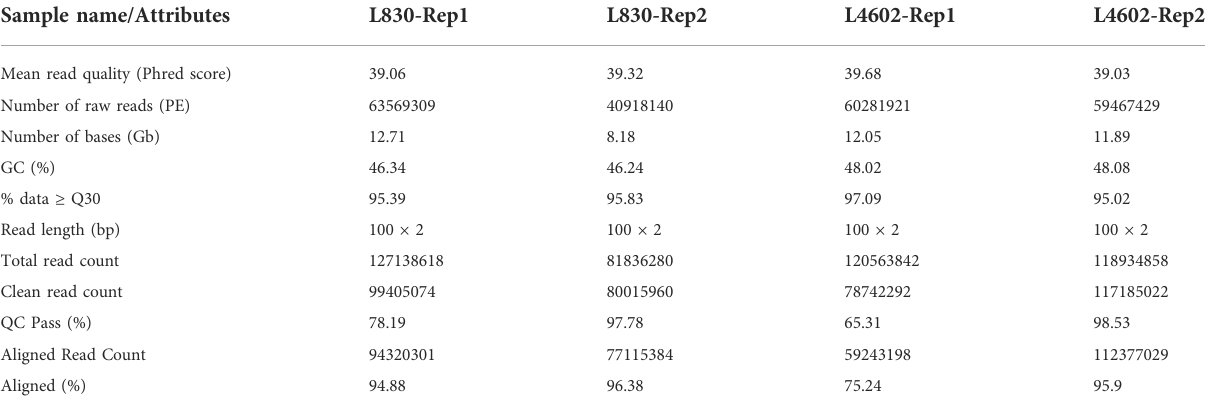
TABLE 2 Summary of RNA-seq data in four developing seeds samples of lentils (small- and large-seeded).